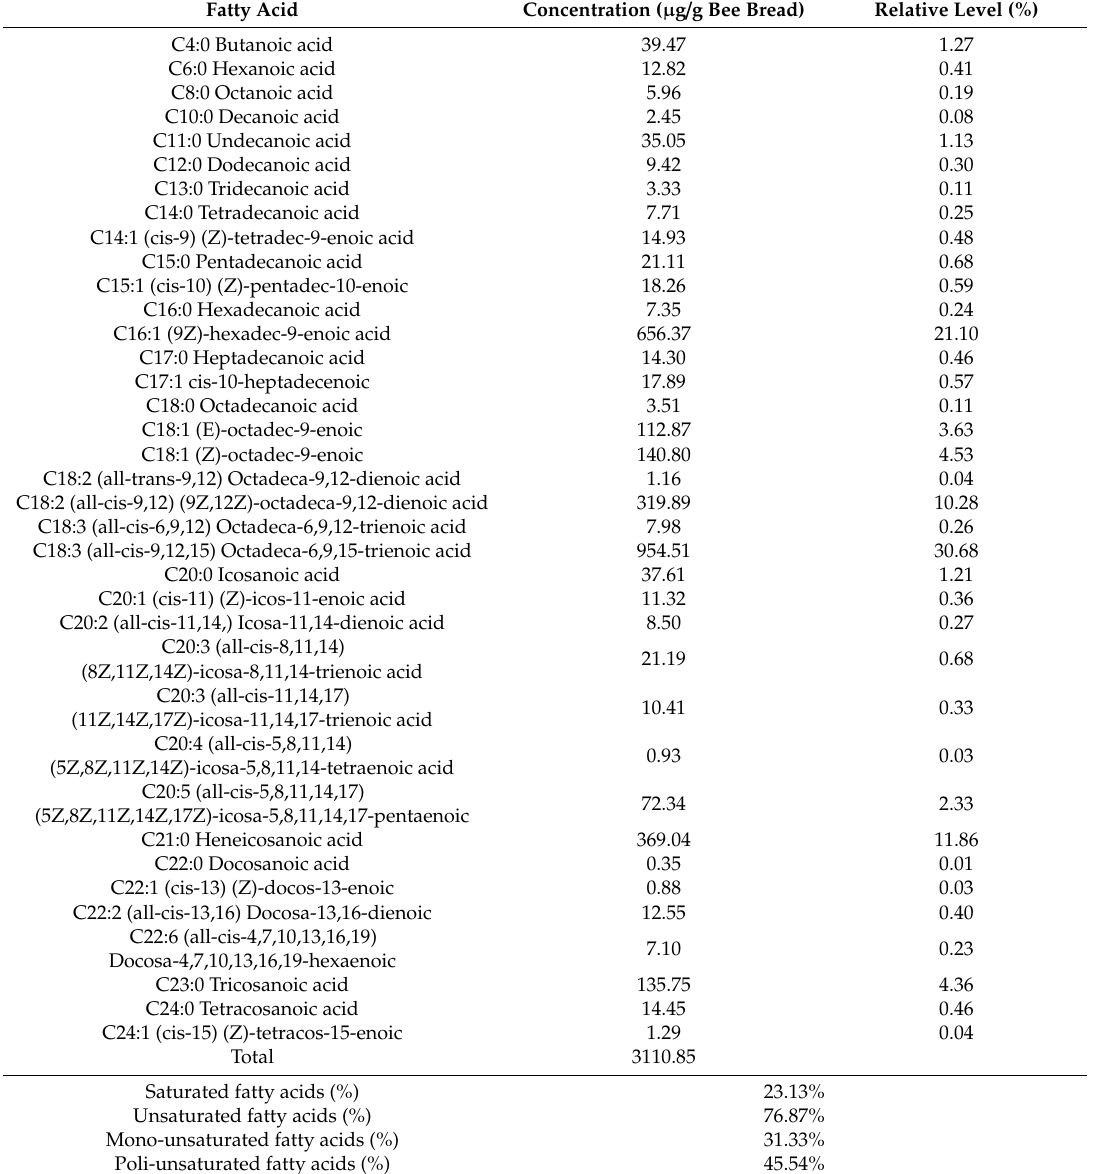
Table 6. Fatty acids composition of bee bread